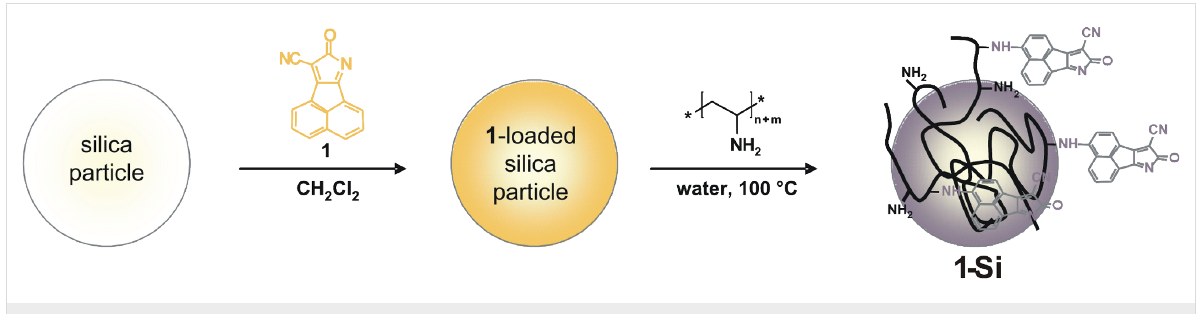
Scheme 3: Synthesis of 1-Si by nucleophilic aromatic substitution of 1 adsorbed onto silica particles.